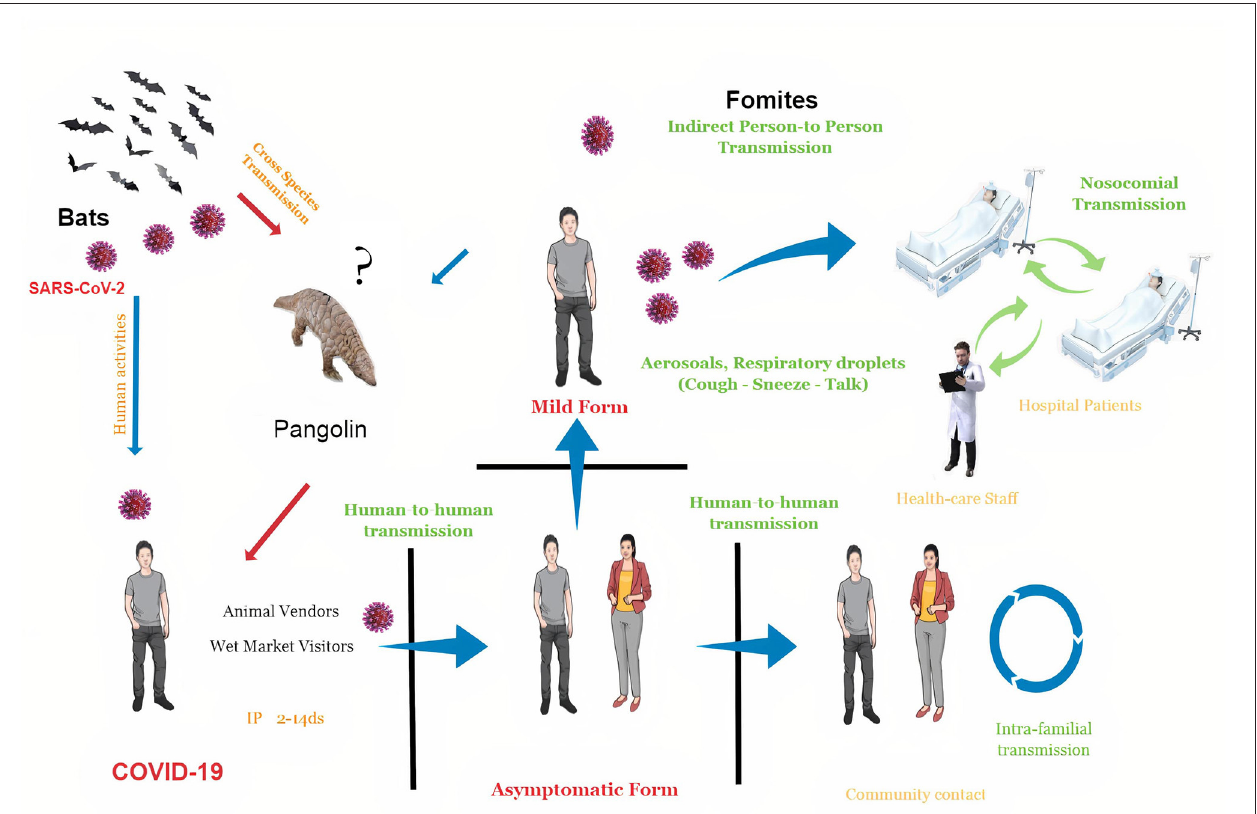
FIGURE 1 | The schematic diagram of coronavirus disease 2019 (COVID-19) spread. Severe acute respiratory syndrome coronavirus 2 (SARS-CoV-2) is most likely spread from bats to people through intermediate hosts like pangolins or other wild animals sold at Huanan local Seafood Wholesale market, Wuhan, Hubei Province, China. Human-to-human transmission is established once the virus has been transferred in this manner. Nosocomial transmission (viral spread between persons inside hospitals, such as doctors, nurses, and patients) and intrafamilial transmission (viral spread between family members) are the most common kinds of human-to-human transmission.SARS-CoV-2 is transmitted through aerosol droplets and fomites. The disease has a 2- to 14-day incubation period and can cause mild, moderate, severe, or even asymptomatic forms.